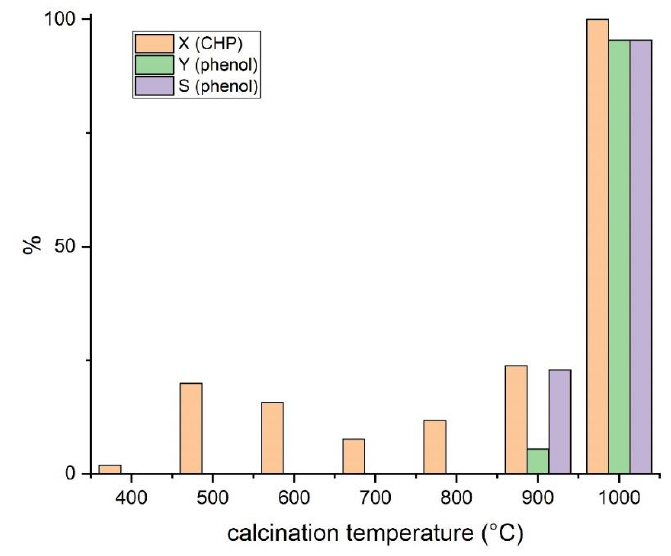
Figure 4. Yield of phenol in the Hock rearrangement of CHP in chloroform with different catalysts; 45 bar, 80 ◦ C, 8.62 mL substrate.